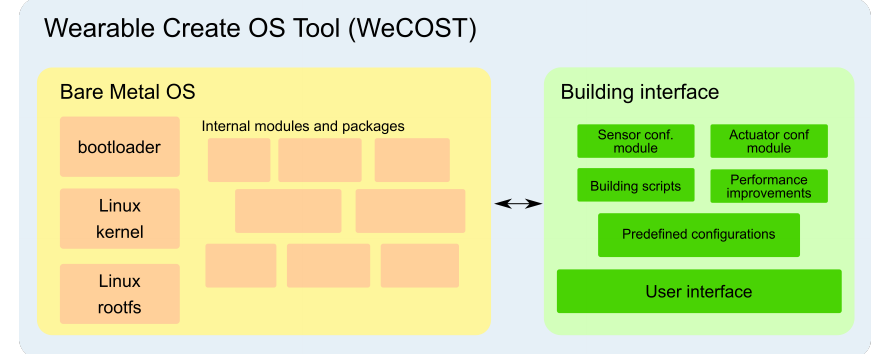
Figure 3. General architecture, main blocks and internal organization of wearable create operating system tool (WeCOST)